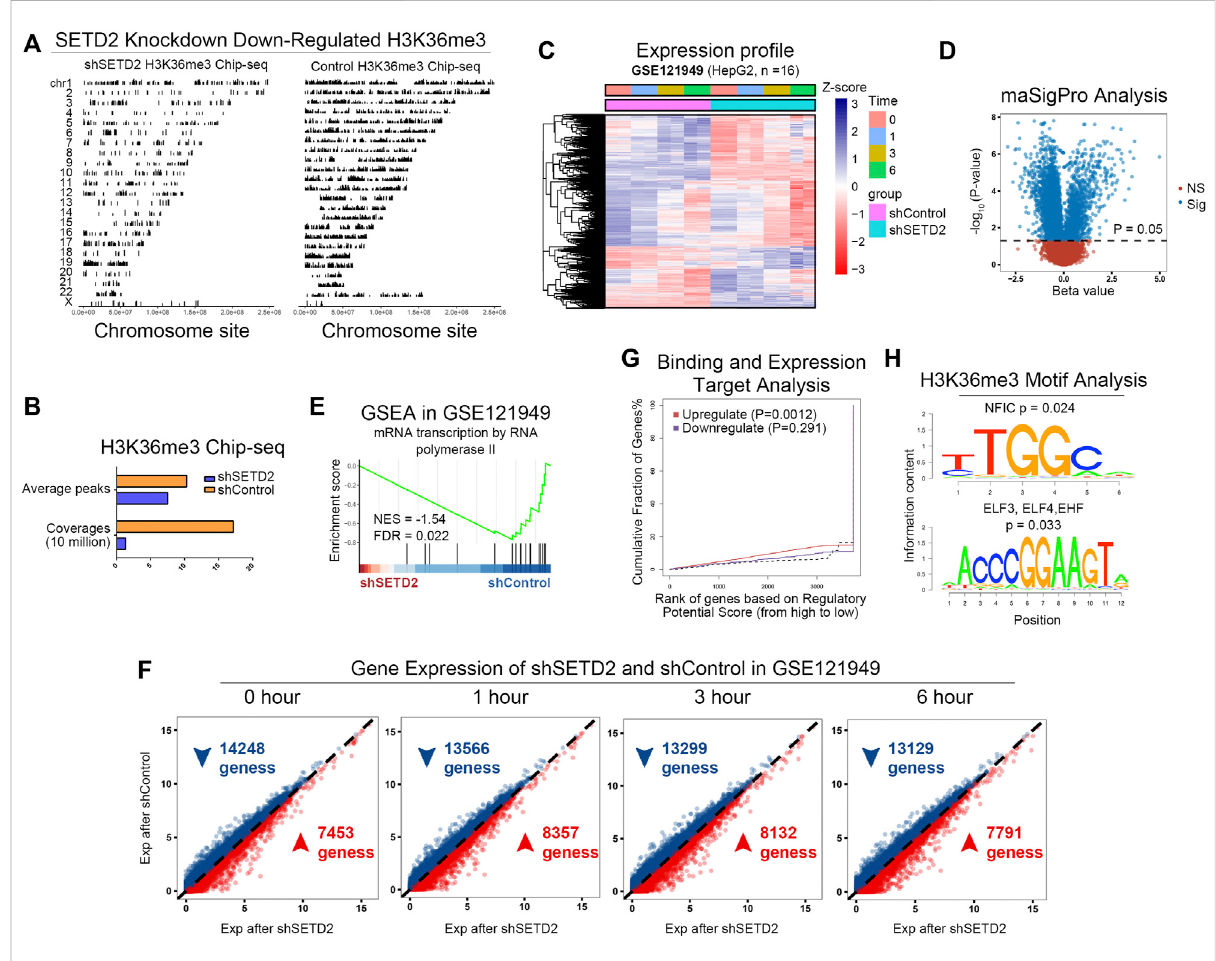
FIGURE 2 SETD2 and H3K36me3 enhanced transcription. (A) The H3K36me3 signals of shSETD2 vs. control in GSE110318. (B) The quantitative H3K36me3signals. (C) Expressionpro fi leofGSE121949. (D)